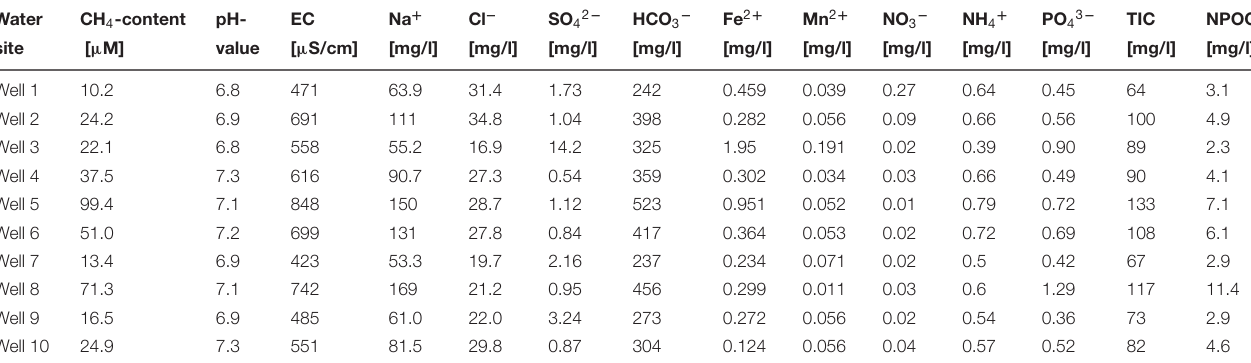
TABLE 1 | Methane content and geochemical properties of groundwater samples collected from wells located in coal-rich sediments.